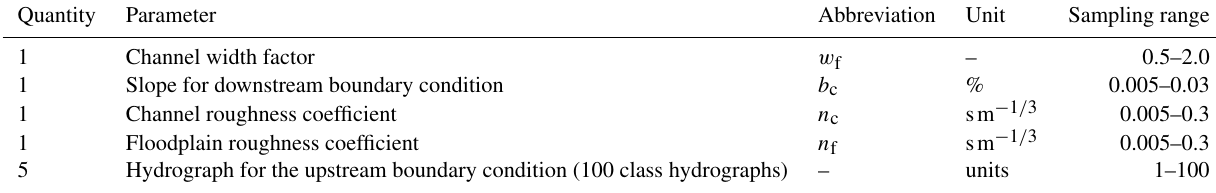
Table 3. Sampling range of parameters to run the hydraulic model.